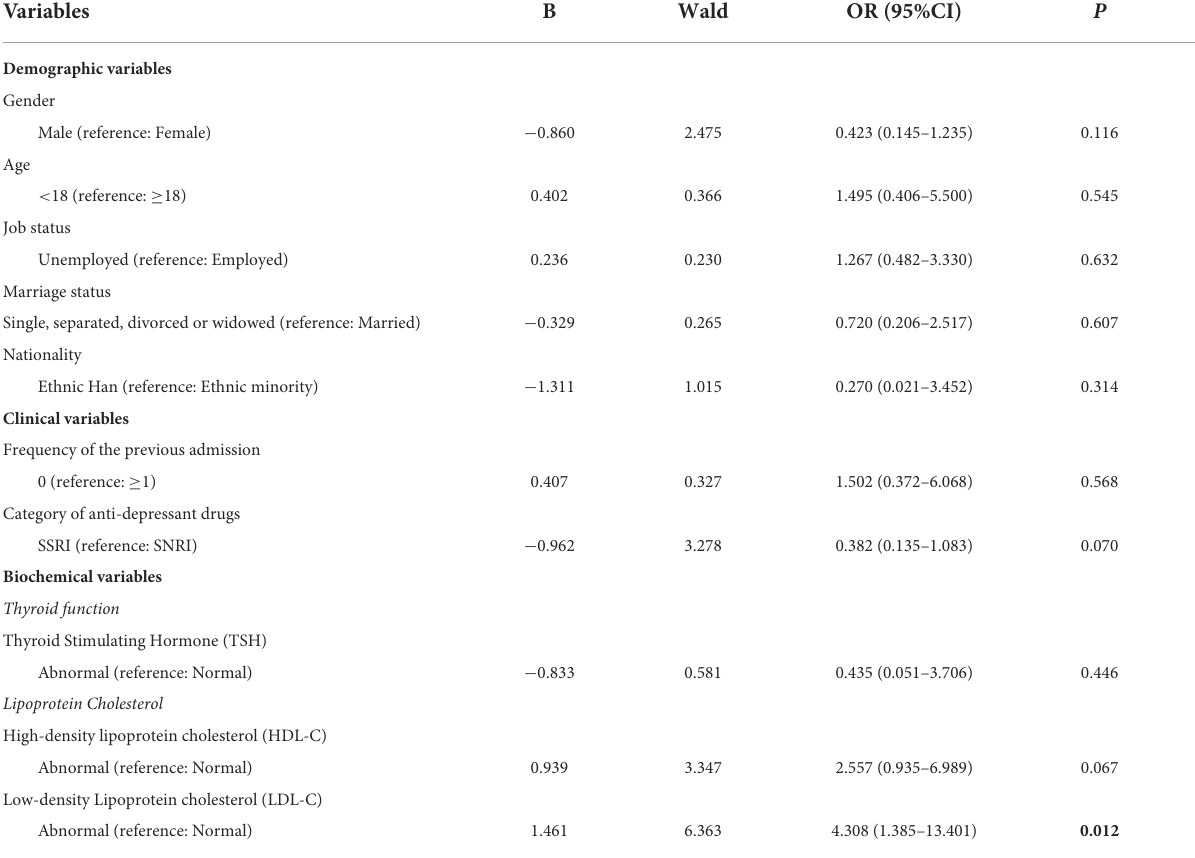
TABLE 2 Binominal logistic regression analysis of the LOS among patients with major depressive